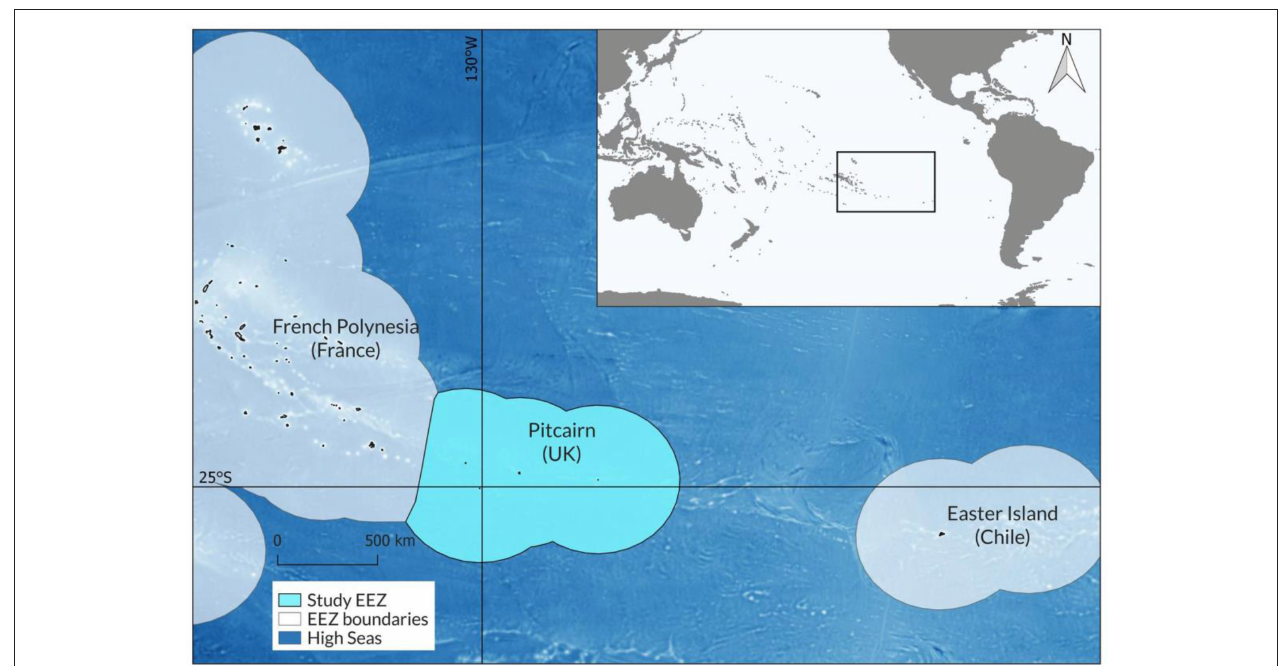
FIGURE 1 | The Exclusive Economic Zone (EEZ) of the Pitcairn Islands, an overseas territory of the United Kingdom (UK), and the EEZs of neighboring French Polynesia (a territory of France) and Easter Island (a territory of Chile), with surrounding High